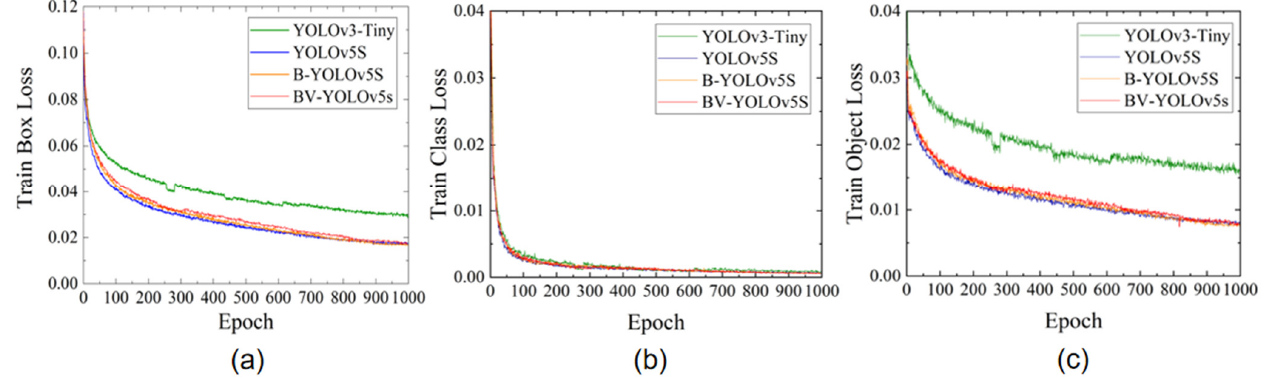
Figure 6. Comparison of training losses of four models. ( a ) train box loss. ( b ) train class loss. ( c ) train object loss.